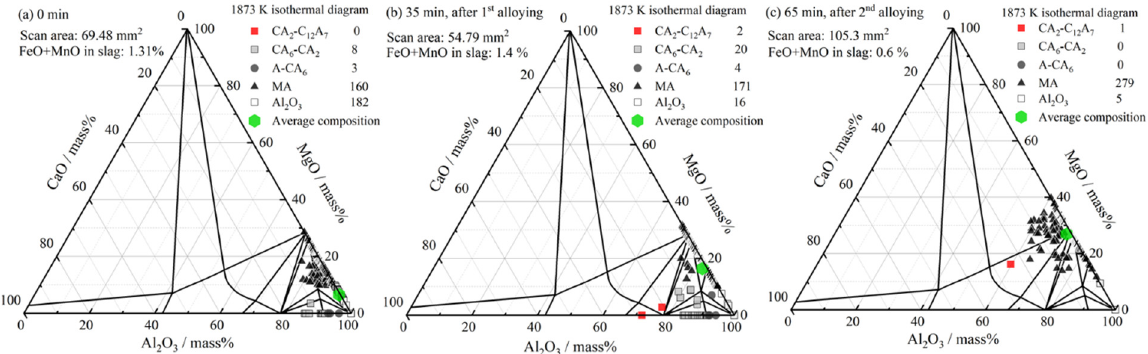
Figure 15. Observed inclusions in heat 4 at ( a ) 0 min, ( b ) 23 min after the 1st alloying, and ( c ) 51 min after the 2nd alloying.